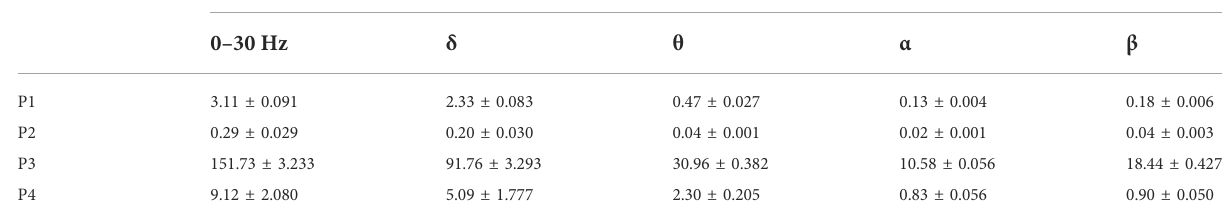
TABLE 1 LFPs power value of each frequency band at each period. Period Power of different frequency bands